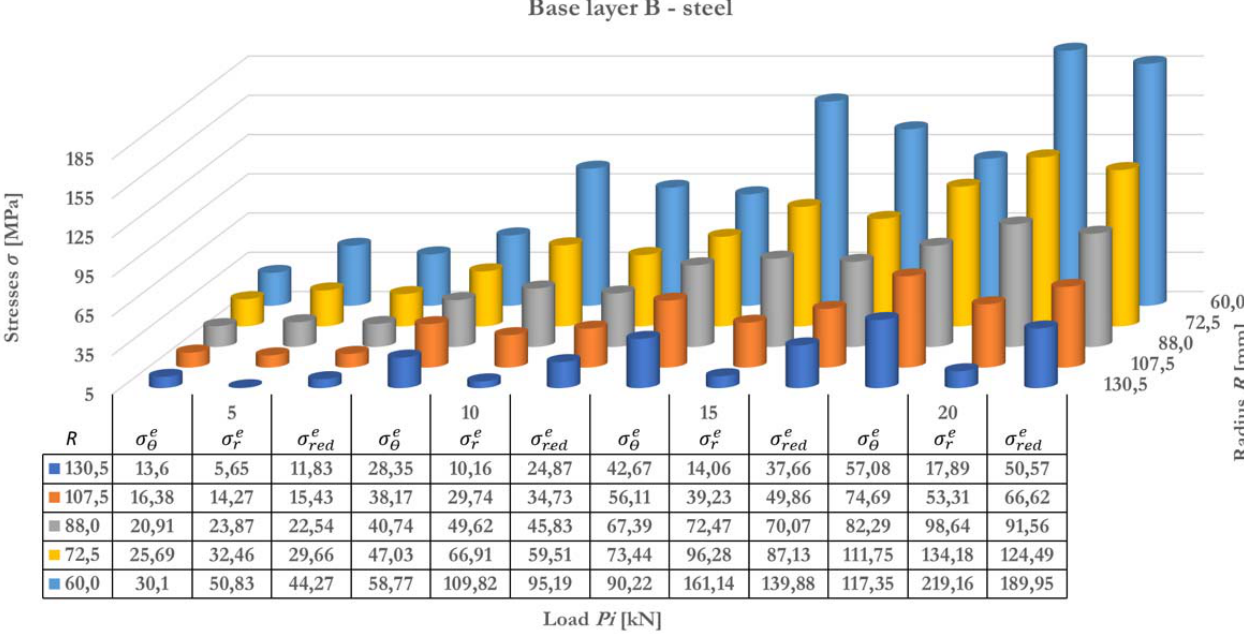
Figure 9: Summary of the stress values, respectively:   ,  r  red determined on the surface of the base layer of the plate B - steel., in this case, the load was applied from the side of the steel